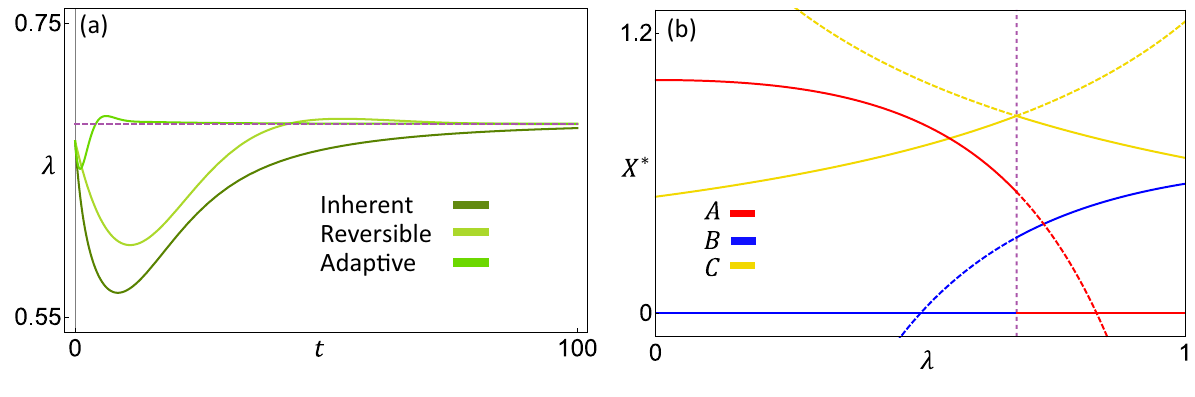
Figure 3. ( a ) Time series of (cid:31) for systems with each kind of heterogeneity. All three systems stabilize at the same (cid:31) ∗ value, which is the bifurcation point in panel ( b ). ( b ) Equilibrium population of each species X = A , B , or C , with (cid:31) held fixed at different values. Solid curves represent stable equilibria and dashed curves represent unstable equilibria (see Eq. (9) in “Methods”). The vertical dashed line is where (cid:31) = (cid:31) ∗ , which is also the bifurcation point. Notice that the equilibrium population of C is maximized at this point (for a 1 > a 2 and b 2 > b 1 ). Parameters used here are ( a 0 , a 1 , a 2 , b 0 , b 1 , b 2 , ρ , η 1 , η 2 , κ) = ( 0.25, 0.5, 0.2, 0.4, 0.2, 0.6, 0.5, 0.05, 0.05, 50 )